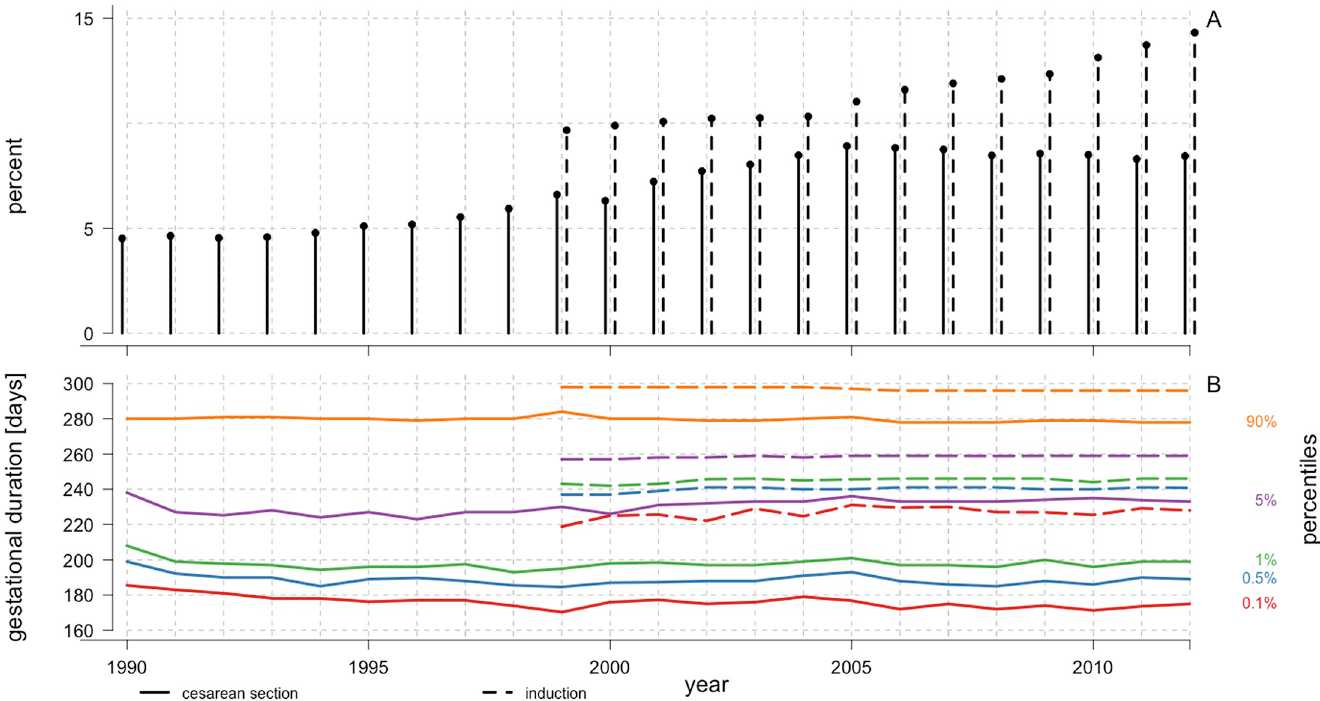
Fig 5. Prevalence of iatrogenic onset deliveries, Swedish Medical Birth Register, 1990–2012. A) Percentage of iatrogenic-onset delivery with regard to the type of medical intervention, i.e. cesarean section (solid line) or induction (dashed line). B) Gestational duration by percentiles (0.1 th , 0.5 th , 1 st , 5 th , and 90 th percentiles, respectively marked by different colors in the cesarean section [solid line] and labor induction [dashed line] cohorts). Due to limited data availability, the cesarean section and induced labor cohorts were restricted between 1990 and 2012 and 1999 and 2012; n = 155 647 and 157 191, respectively.